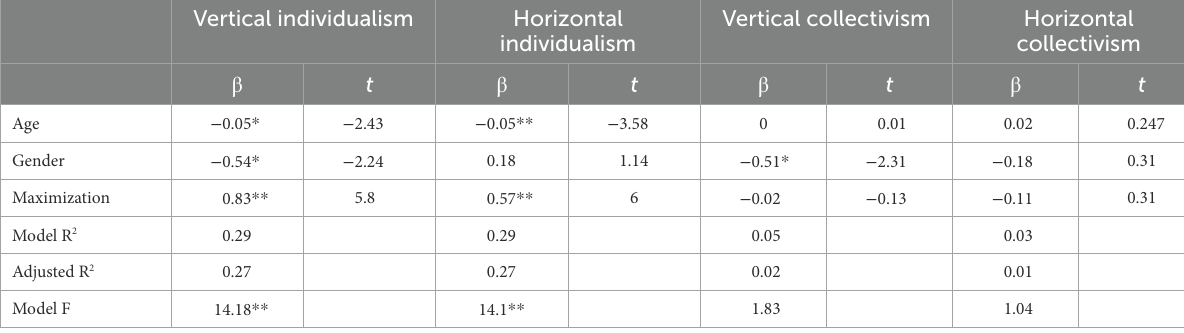
TABLE 4 Regression results for vertical and horizontal individualism and